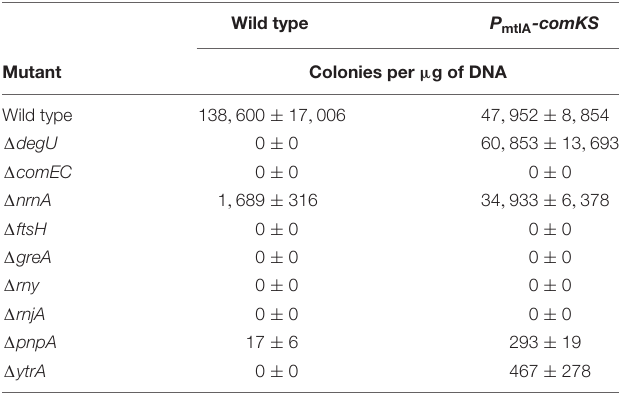
TABLE 3 | Effect of gene deletions on the development of genetic competence in dependence of the competence transcription factor ComK a . Wild type P mtlA -comKS Mutant Colonies per µ g of